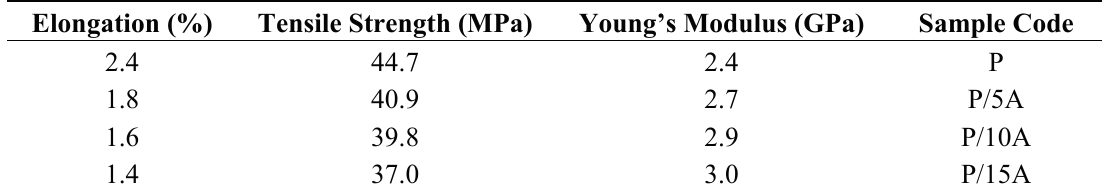
Table 3. Dependency of tensile properties of Poly Methyl Methacrylate (PMMA) on Alumina